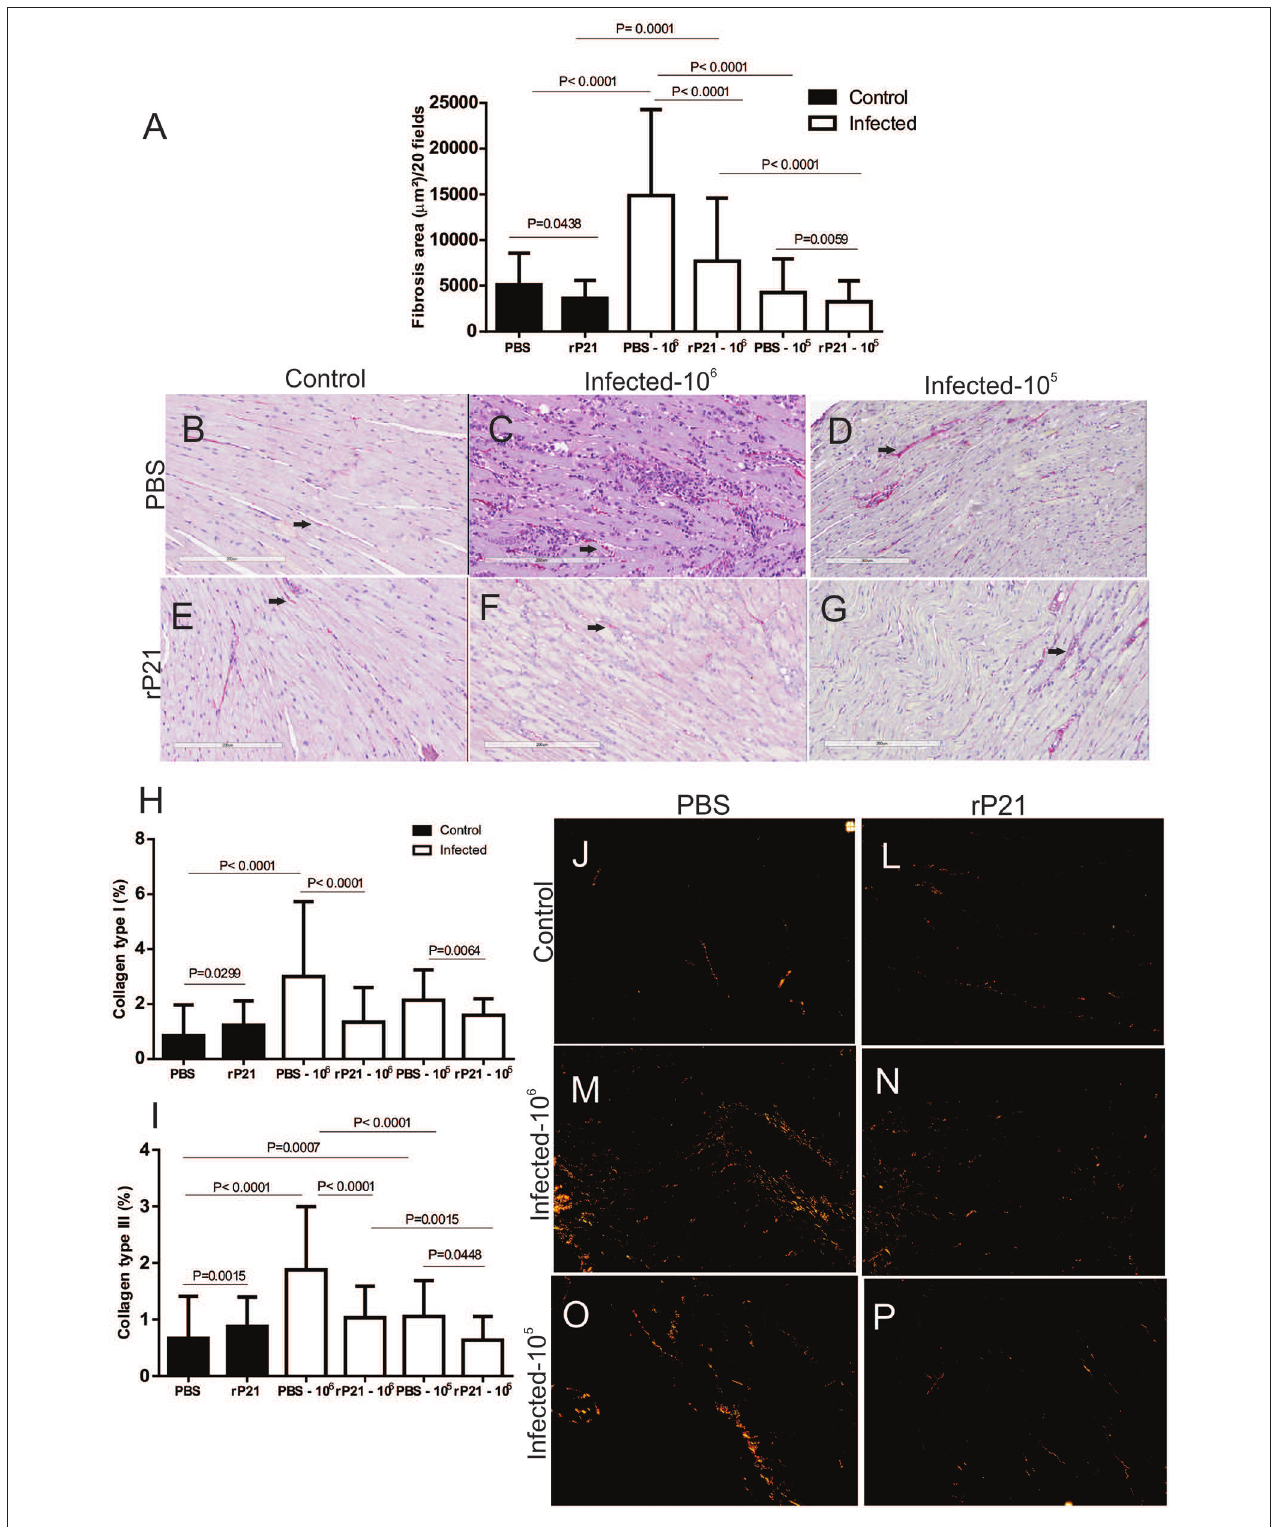
FIGURE 5 | rP21 decreases fibrosis and levels of collagen type I and III in cardiac tissue. (A) Total heart collagen quantification shows that treatment with recombinant protein resulted in a decrease in total fibrosis area and in the percentage of type I (H) and type III (I) collagen in cardiac tissue. Representative images are shown